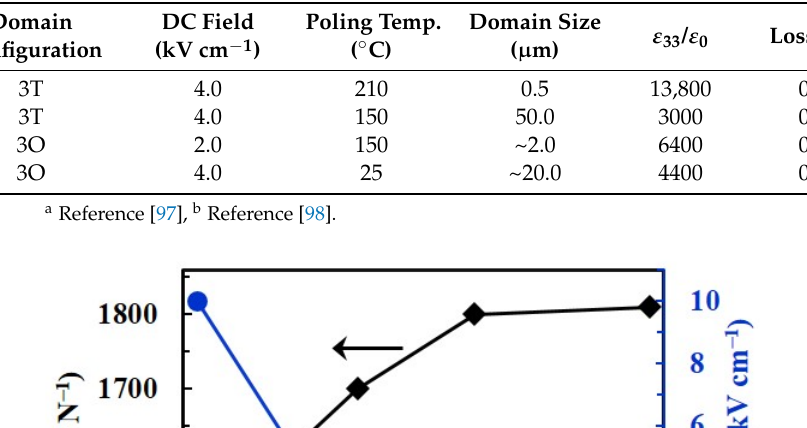
Table 2. Property comparison of DCP at different temperatures.